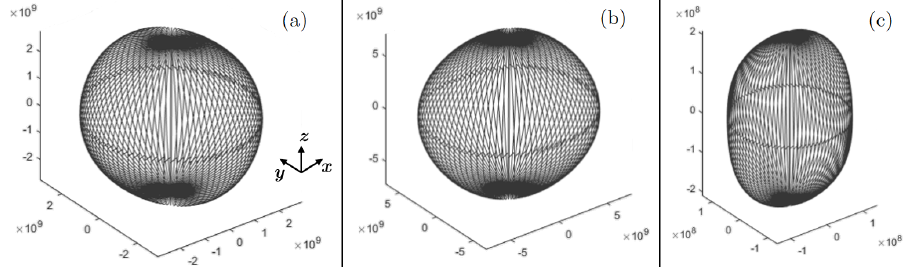
Figure 20. 3D anisotropy maps for ( a ) the closed-cell foam specimen with Procedure 1, ( b ) the closed-cell foam specimen with Procedure 2 and ( c ) the cubic open-cell foam